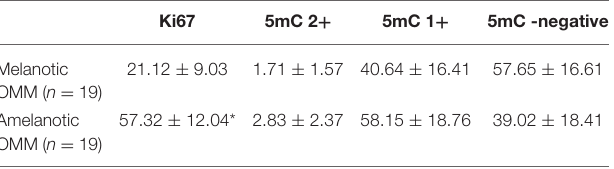
FIGURE 1 | Scores of the 5mC-positive nuclei in samples of canine melanotic and amelanotic OMMs. The 5mC-positive cells were divided into strong (2 + ), weak (1 + ), or negative (0) staining. Medians were compared by Kruskal Wallis, with the Dunn’s post-test . No significant differences were obtained. However, more than 90% of the cells in both melanotic and amelanotic OMM samples were either weakly or negatively stained for